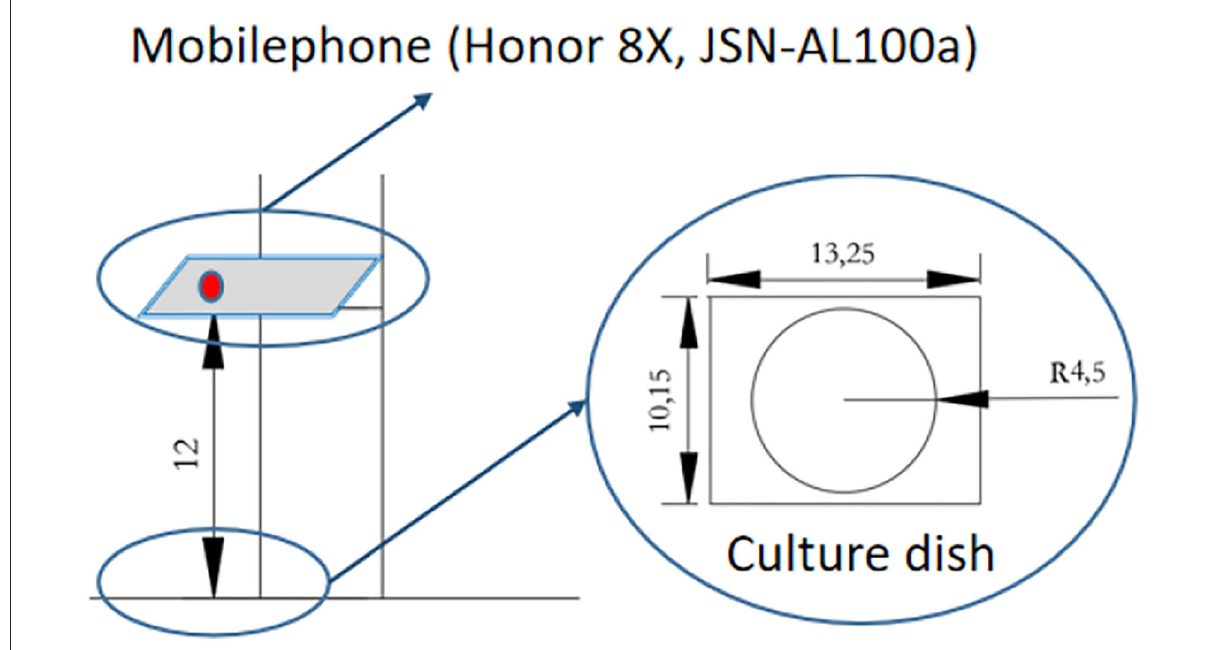
FIGURE1 Schematic drawing of the image acquisition method.